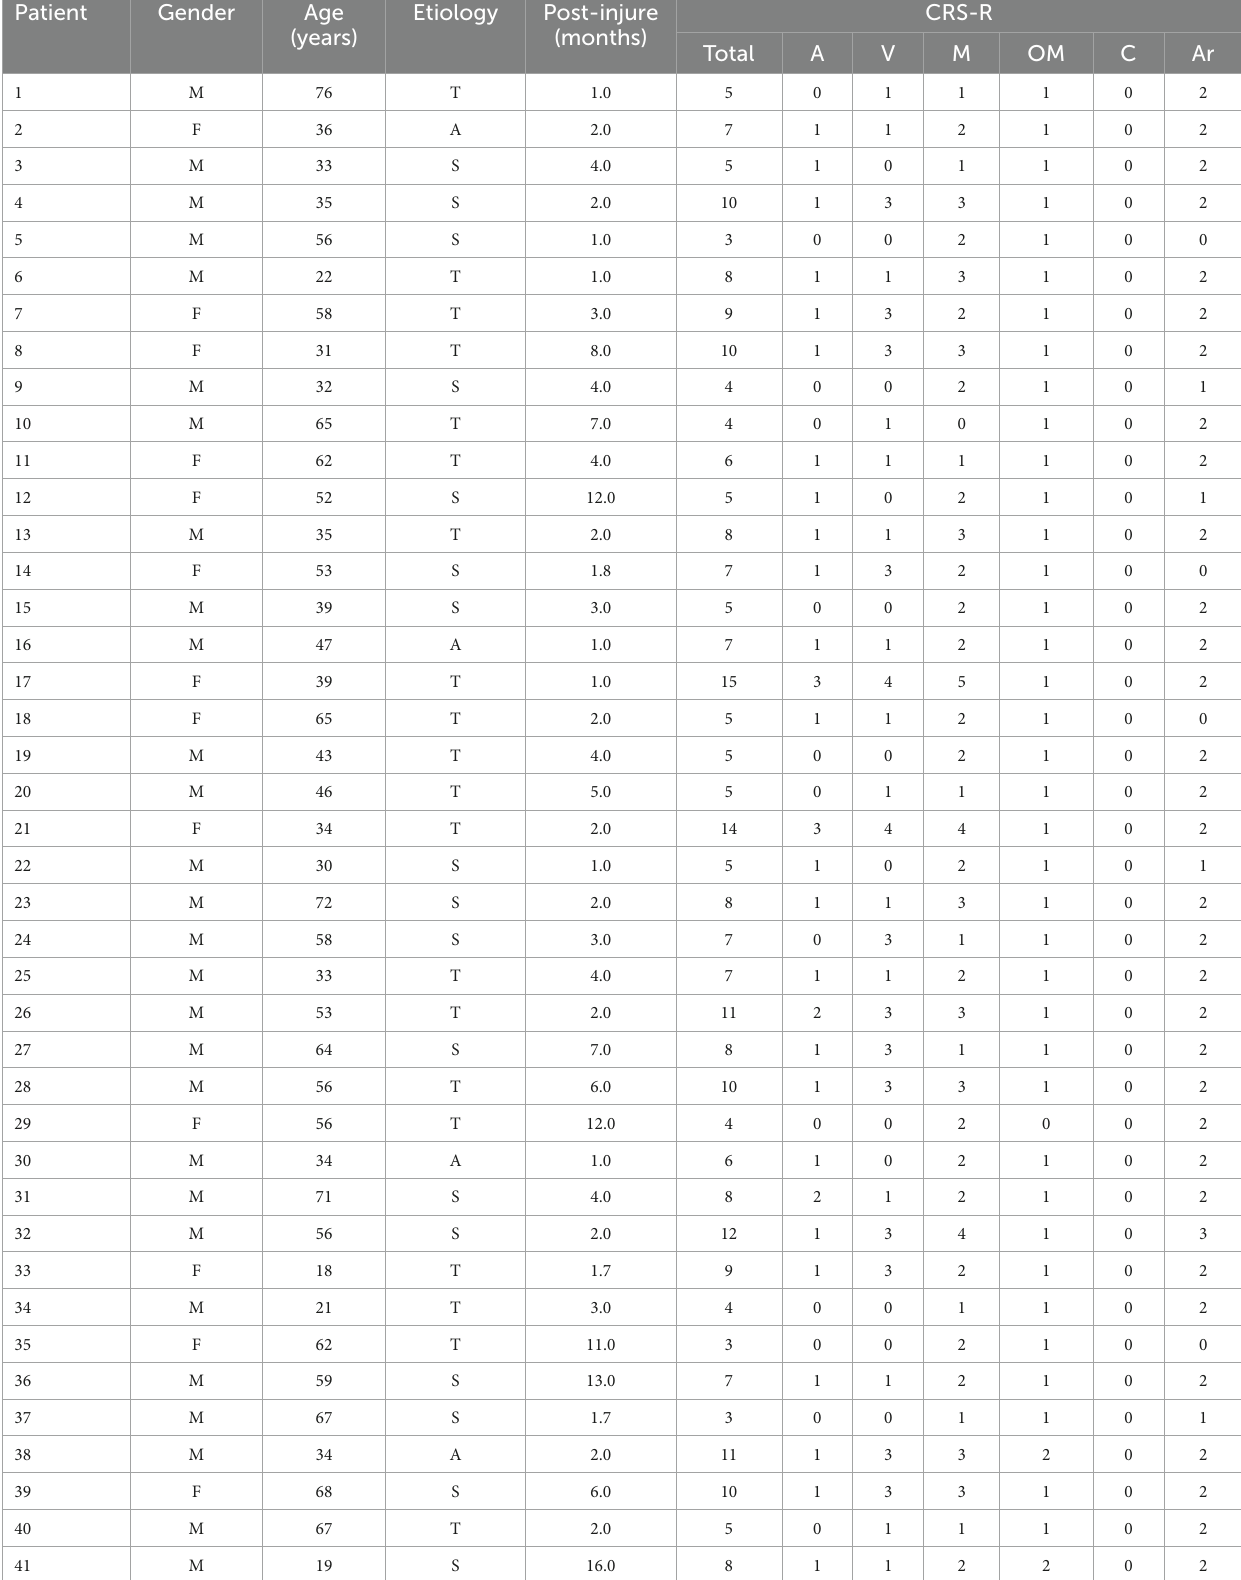
TABLE 1 Details of DOC patients participating in real-time EEG monitoring during HBO